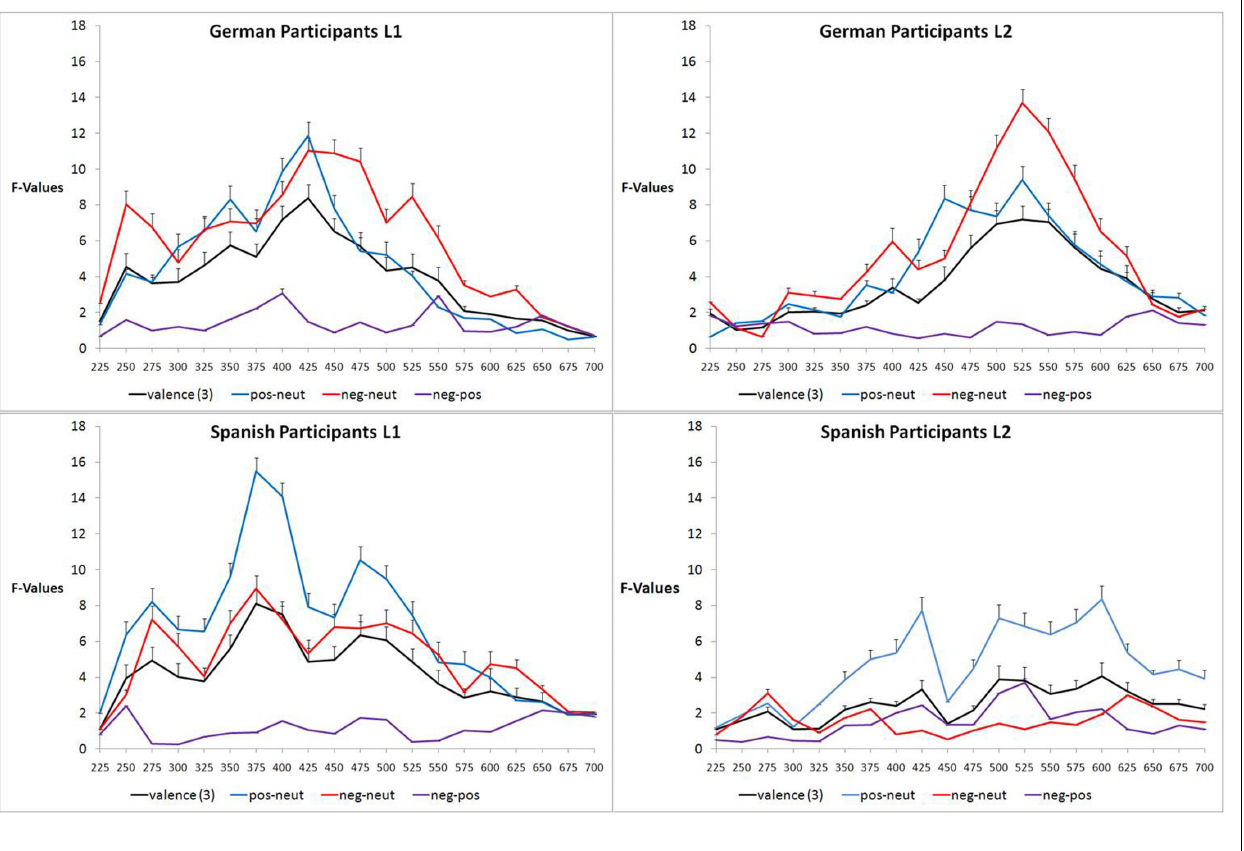
FIGURE 1 | F -values fromANOVAs for 26 Spanish and 26 German participants over mean ERP amplitudes in 25ms time epochs from 200ms until 700ms (numbers represent the end of respective time windows) after stimulus onset. Reported F -values refer to interactions of